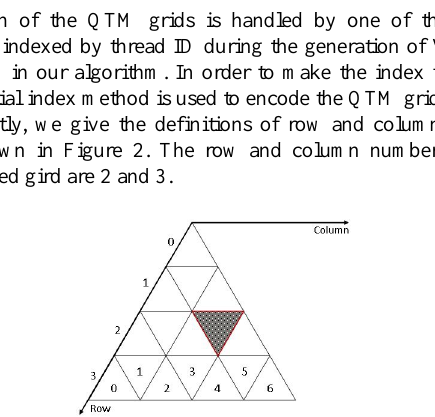
Figure 2. The definition of Row and Column